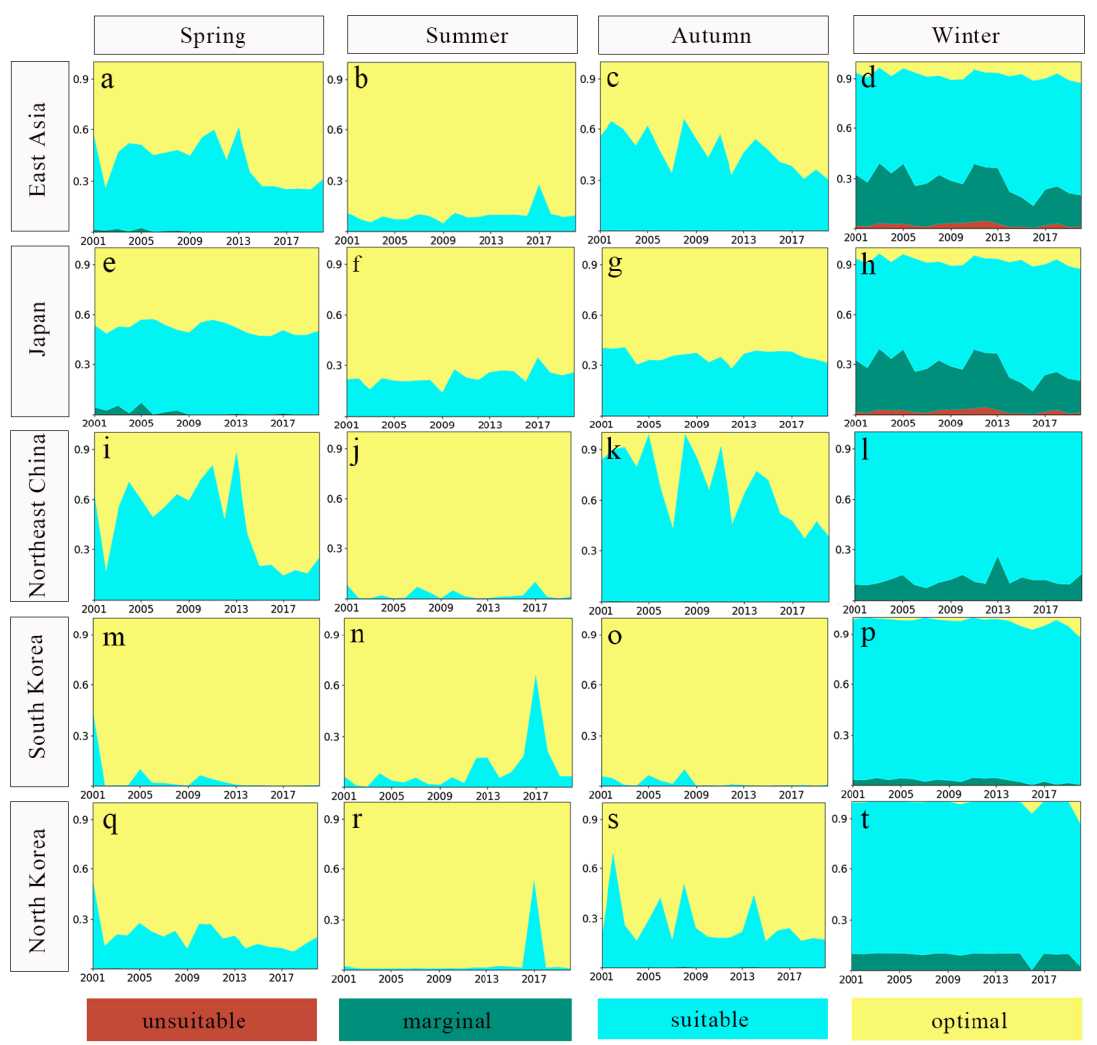
Figure 7. Land area proportions of different suitability levels of ( a ) East Asia in spring, ( b ) East Asia in summer, ( c ) East Asia in autumn, ( d ) East Asia in winter, ( e ) Japan in spring, ( f ) Japan in summer, ( g ) Japan in autumn, ( h ) Japan in winter, ( i ) Northeast China in spring, ( j ) Northeast China in summer, ( k ) Northeast China in autumn, ( l ) Northeast China in winter, ( m ) South Korea in spring, ( n ) South Korea in summer, ( o ) South Korea in autumn, ( p ) South Korea in winter, ( q ) North Korea in spring, ( r ) North Korea in summer, ( s ) North Korea in autumn, and ( t ) North Korea in